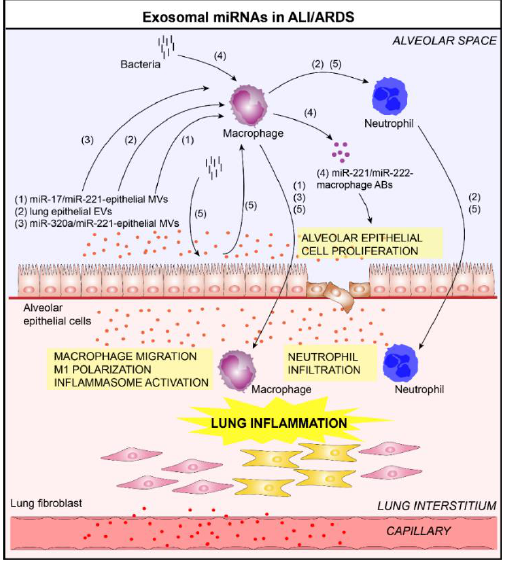
Figure 4. Role of lung EVs in the pathogenesis of Acute Lung Injury / Acute Respiratory Distress Syndrome (ALI / ARDS) ( 1–5 ). In the context of ALI / ARDS, EVs released by bronchial ECs and alveolar macrophages contribute to lung inflammation. Indeed, these vesicles are able to activate macrophages and promote the infiltration of immune cells (macrophages, neutrophils) in the lung in a miRNA transfer-dependent manner (delivery of ( 1 ) miR-17 / miR-221 [51] and ( 3 ) miR-320a / miR-221 [53] in alveolar macrophages via epithelial EVs) or ( 2 ) caspase-3-dependent manner [52]. ( 4 ) In addition, the alveolar macrophages-derived EVs are able to promote the proliferation of lung ECs by delivering miR-221 / 222[54]. ( 5 )Afterbacteriallunginfection, alveolarEC-derivedEVscontributetoinnateimmune responses by delivering miRNAs into alveolar macrophages, subsequently promoting inflammasome activation, neutrophil recruitment, and M1-macrophage polarization